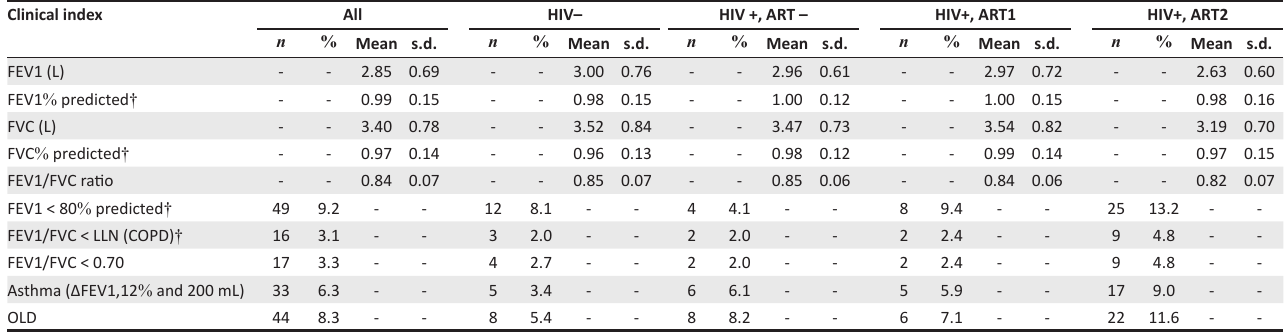
TABLE 2: Post-bronchodilator spirometry results. Clinical